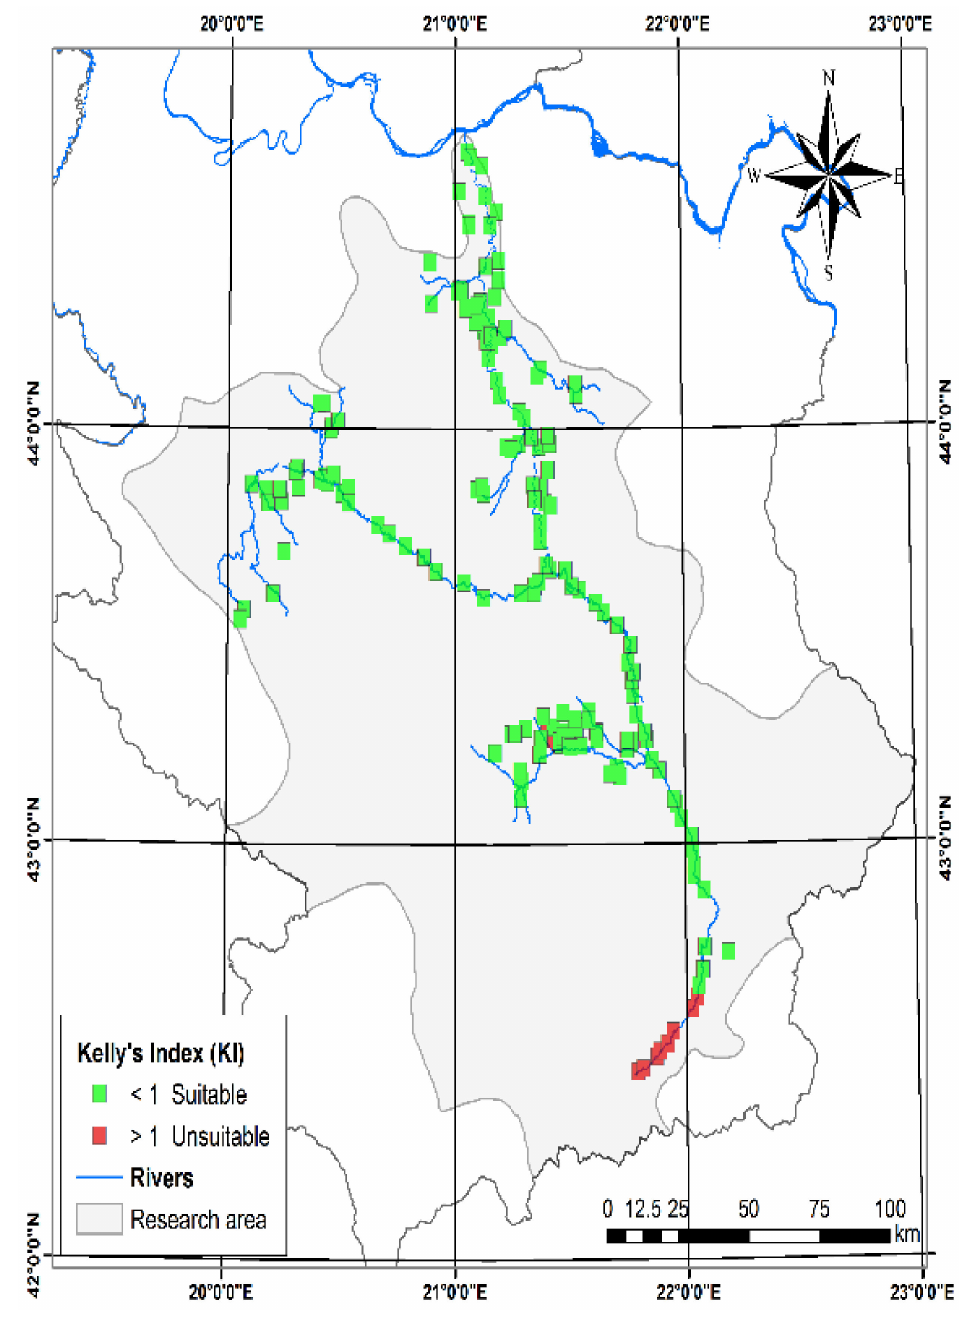
Figure 14. Spatial distribution of